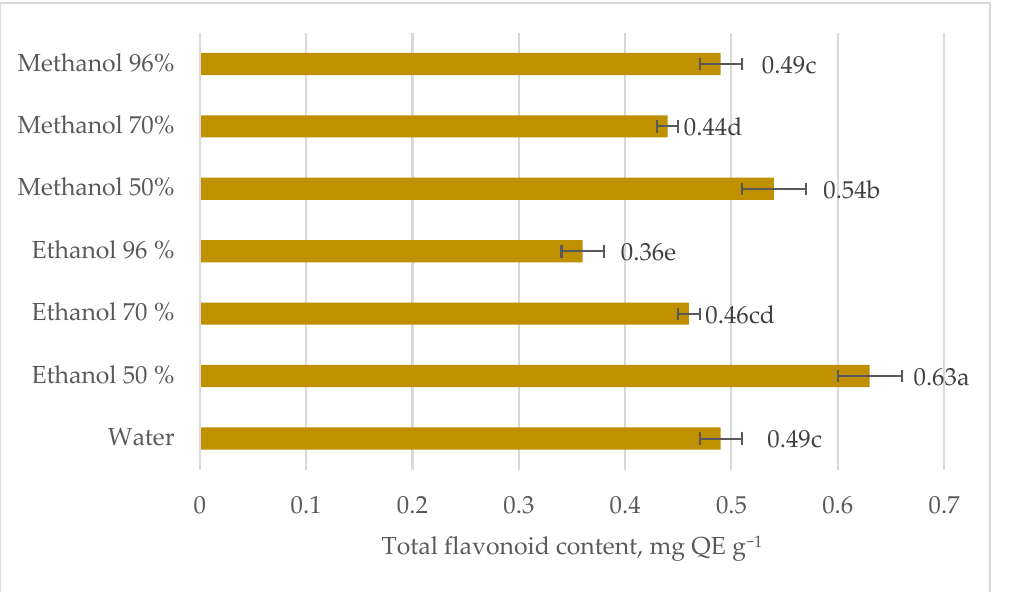
Figure 4. Total flavonoid content in stinging nettle ( Urtica dioica L.) roots extracts, mg QE g − 1 DM .